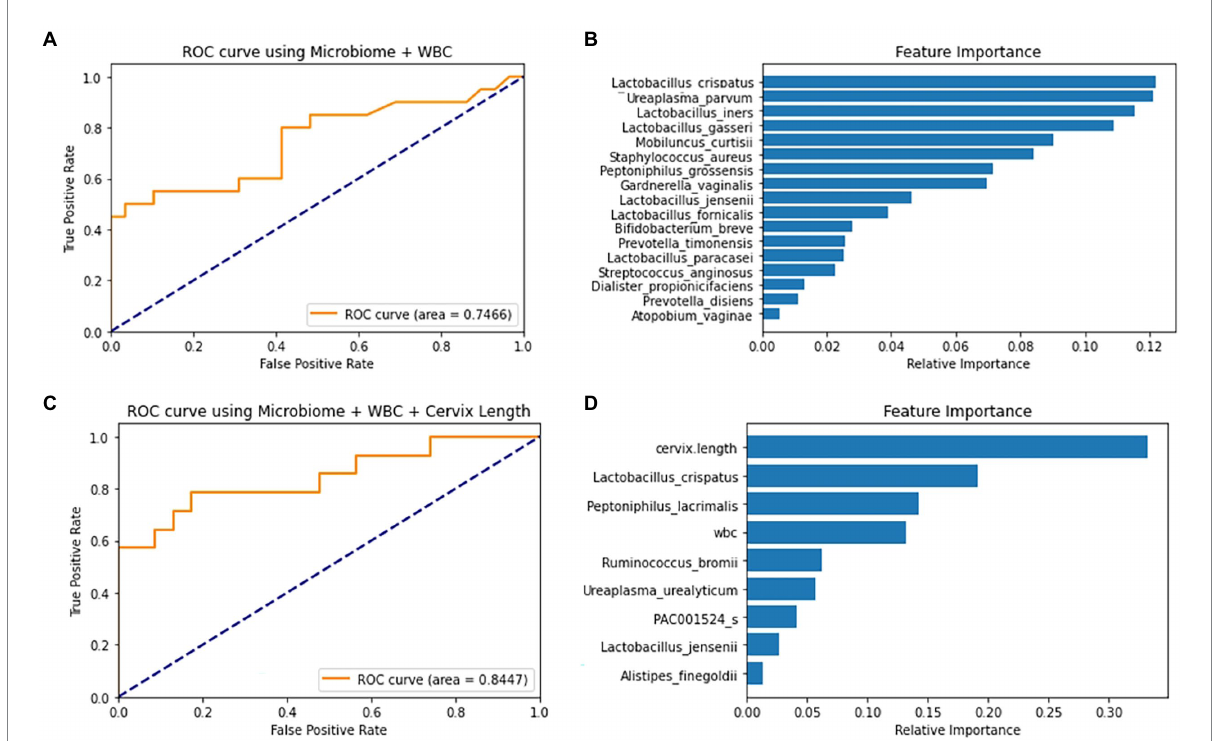
FIGURE 4 ROC curve and feature importance plot of the Random Forest (RF) models using covariates and selected markers. (A) RF model’s ROC curve on test data using 10 selected markers and WBC (B) RF model’s feature importance plot using 10 selected markers and WBC. (C) RF model’s ROC